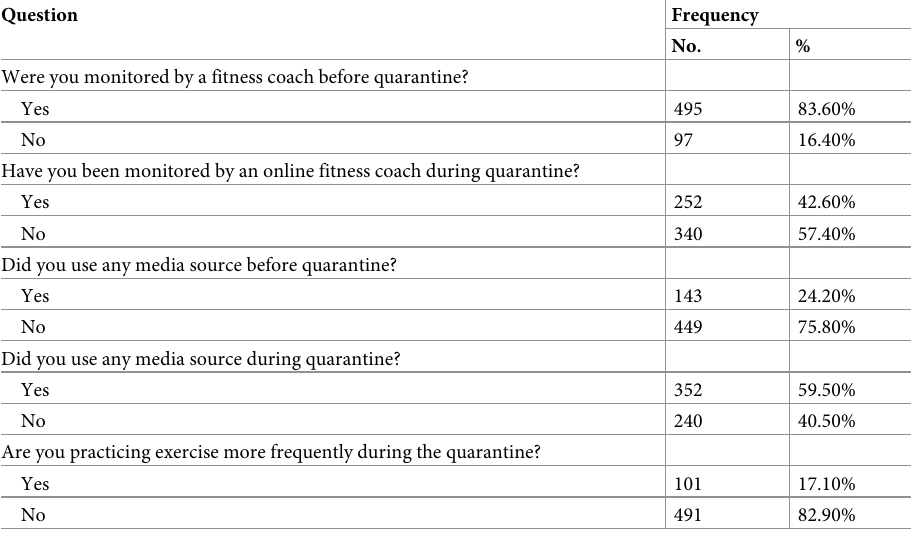
Table 2. Descriptive statistics of categorical variables of exercise routines.